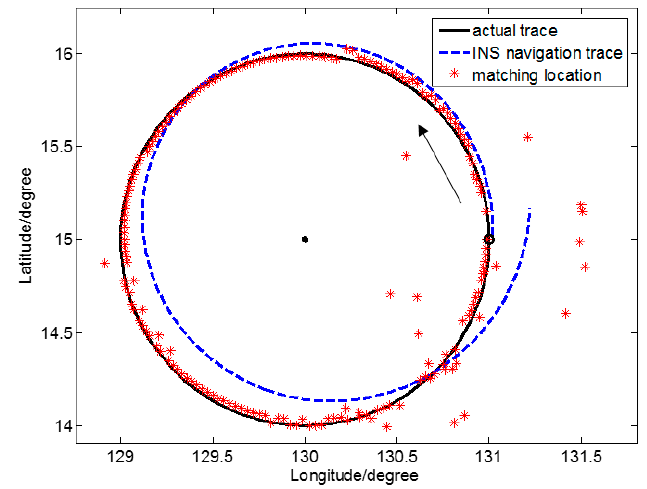
Figure 5. Simulated trace of closed sailing route gravity matching (sailing route A) .